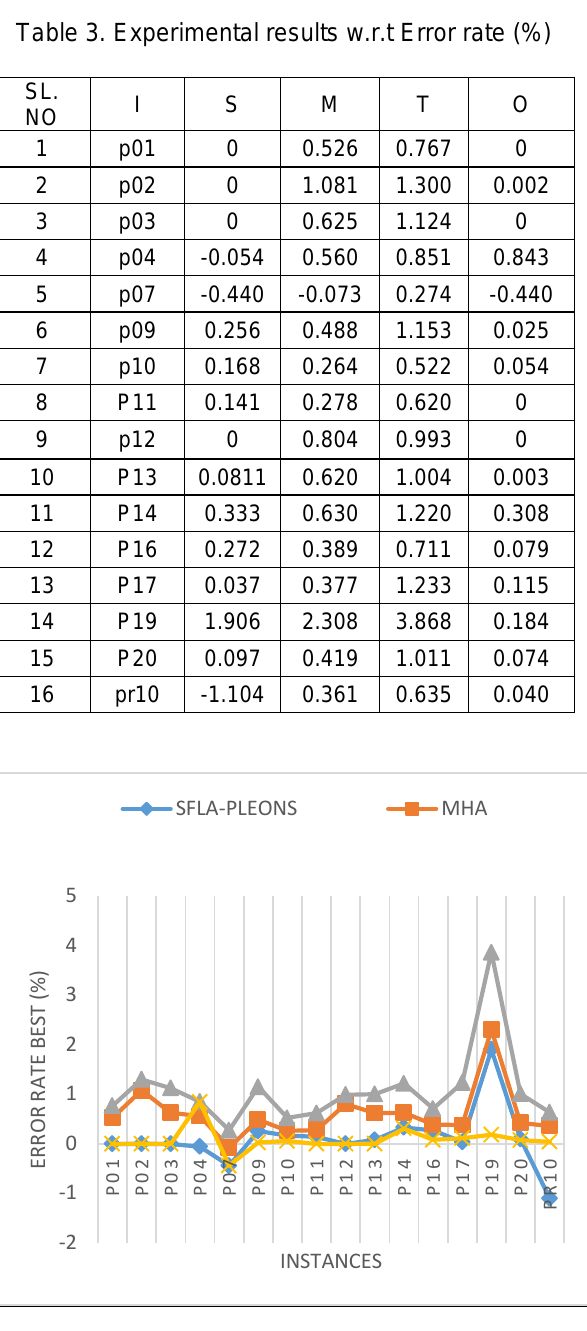
Figure 3. Performance of different technique w.r.t Worst Convergence rate (%)